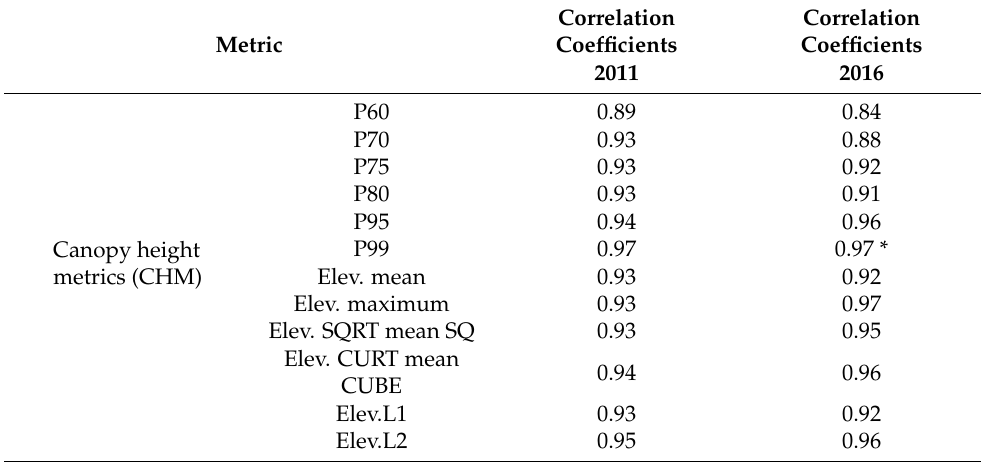
Table 5. Spearman’s correlation coefficients between simulated in DART and ALS-PNOA point clouds. All the variables are significant at the 0.05